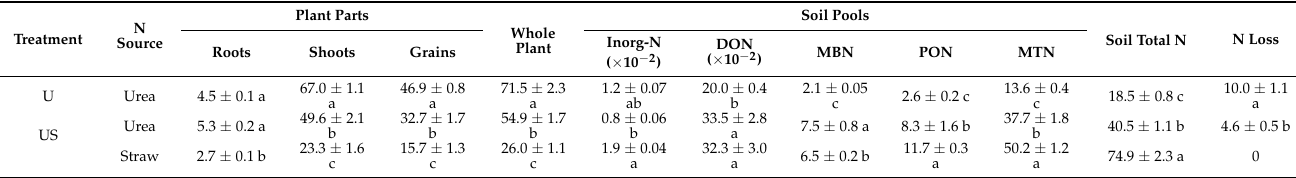
Table 3. Recovery rate of applied N in plant and soil N pools under urea (U) and urea plus straw (U + S) treatments at maturity. Unit: